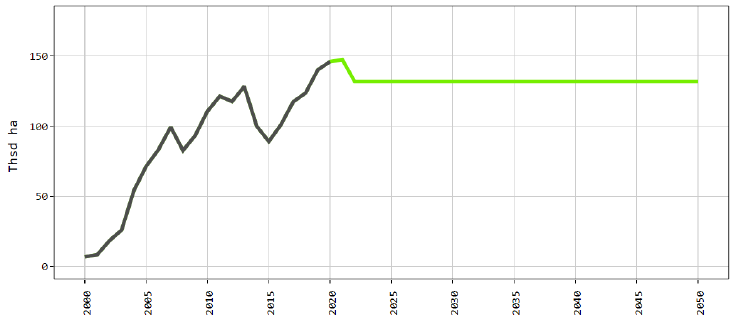
Figure 8. Rapeseed area land in 2000–2020, with a 2021–2050 projection for Latvia, in thousands of hectares [62].